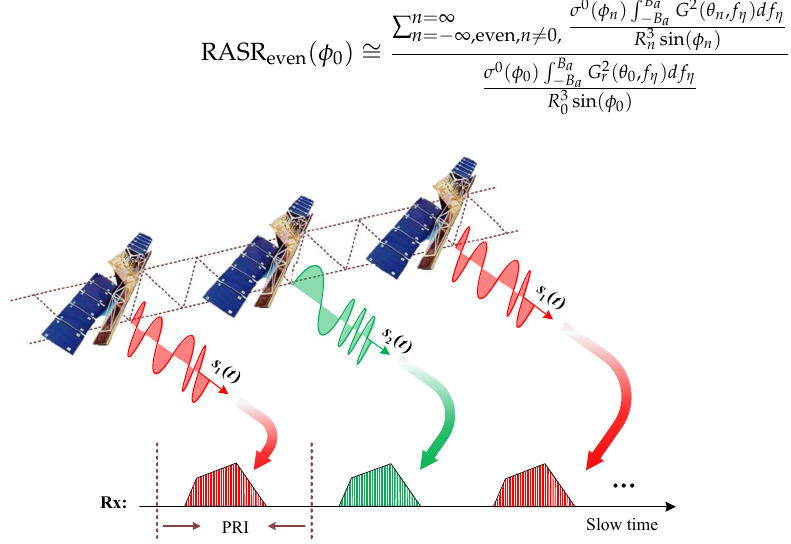
Figure 2. Timing diagram for a single polarization SAR system with waveform